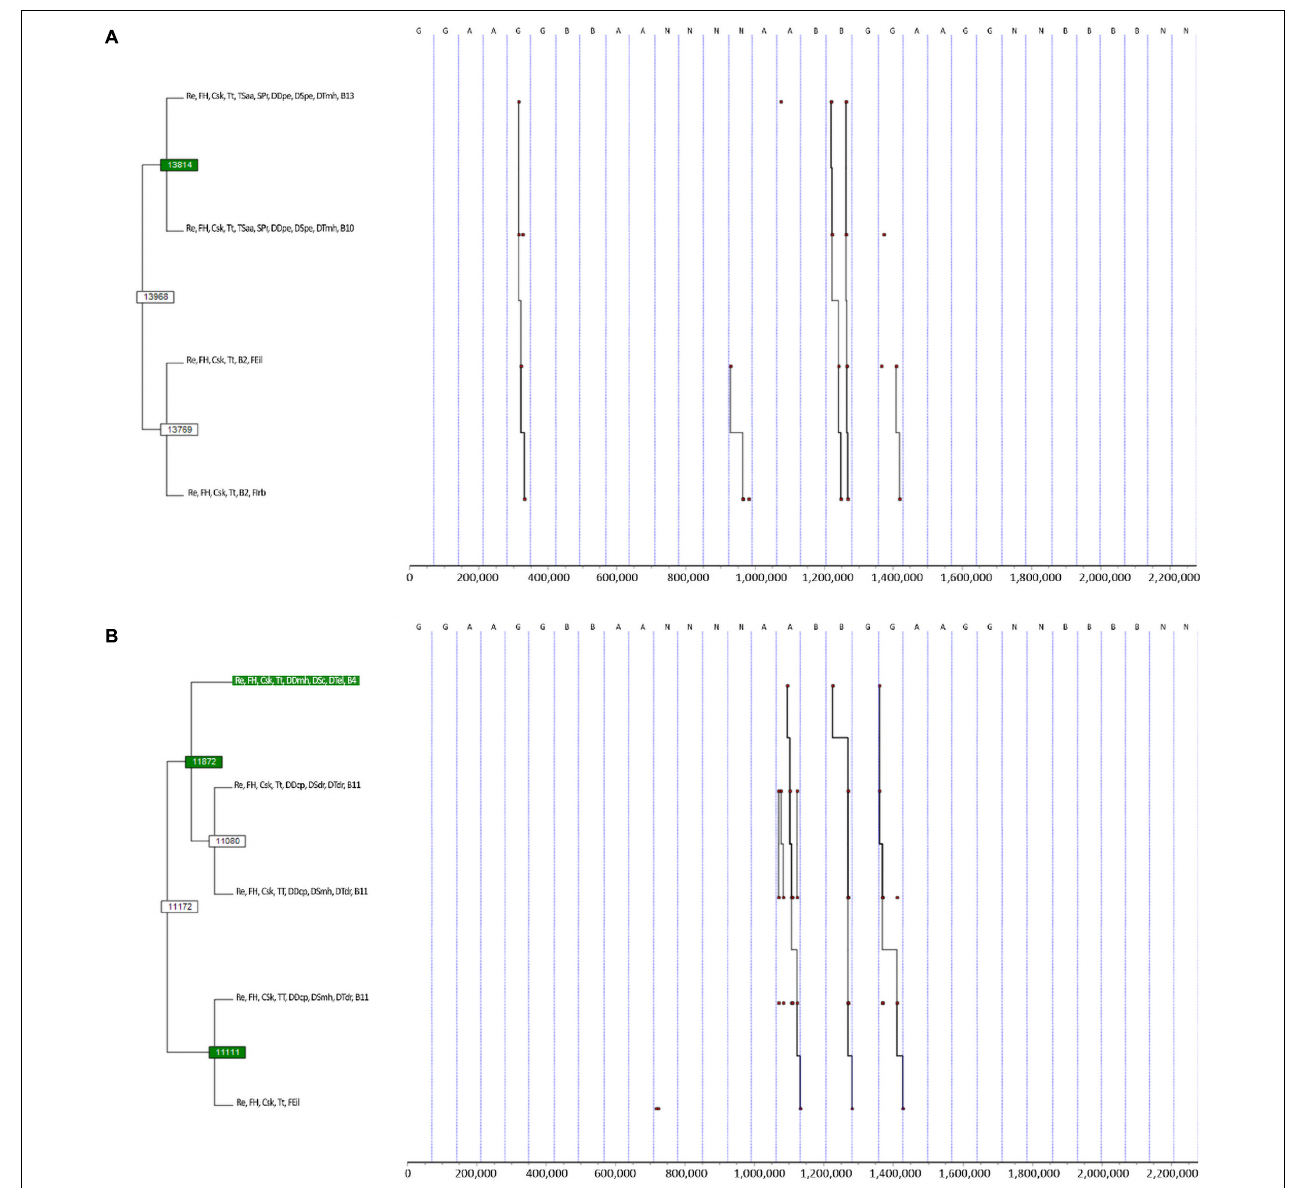
FIGURE 4 | T-pattern detection and analysis of the first, second, and third defender’s tactical–technical actions and ball field zones, with and without the type of subphase and centre of the game, according to match status, opponent quality, type and stage of competition, and halves, using a lumping factor of 0.90 and minimum occurrence of 3. Pattern (A) ((Re, FH, Csk, Tt, Tsaa, SPr, DDpe, DSpe, DTmh, B13 Re, FH, Csk, Tt, TSaa, SPr, DDpe, DSpe, DTmh, B10) (Re, FH, Csk, Tt, B2, FEil Re FH, Csk, Tt, B2, FIrb)); Pattern (B) ((Re, FH, Csk, Tt, DDmh, DSc, DTel, B4 (Re, FH, Csk, Tt, DDcp, DSdr, DTdr, B11 Re, FH, Csk, Tt, DDcp, DSmh, DTdr, B11)) (Re, FH, Csk, Tt, DDcp, DImh, DTdr, B11 Re, FH, Csk, Tt, FEil)); A, Argentina; B, Brazil; B2, ball in the central strip and ultra-defensive sector field zone; B4, ball in the left strip, defensive sector, and defensive midfield field zone; B10, ball in the central strip and offensive sector field zone; B11, ball in the right strip, offensive midfield, and sector offensive sector field zone; B13, ball in the central strip and ultra-offensive sector field zone; Csk, play-offs excluding third place and final; DDcp, first defender pressure; DDmh, first defender player marking; DDpe, first defender control or balance positioning; DSc, second defender contention; DSdr, second defender displacements of recovering; DSmh, second defender player marking; DSpe, second defender control or balance positioning; DTdr, third defender displacements of recovering; DTel, third defender close longitudinal spaces; DTmh, third defender player marking; FEil, end of defensive phase by interruptions and laws infractions; FH, first half; FIrb, end of defensive phase by shot on goal conceded; G, Germany; N, Netherlands; Re, draw; SPr, relative numerical inferiority; TSaa, delay subphase; Tt, tier